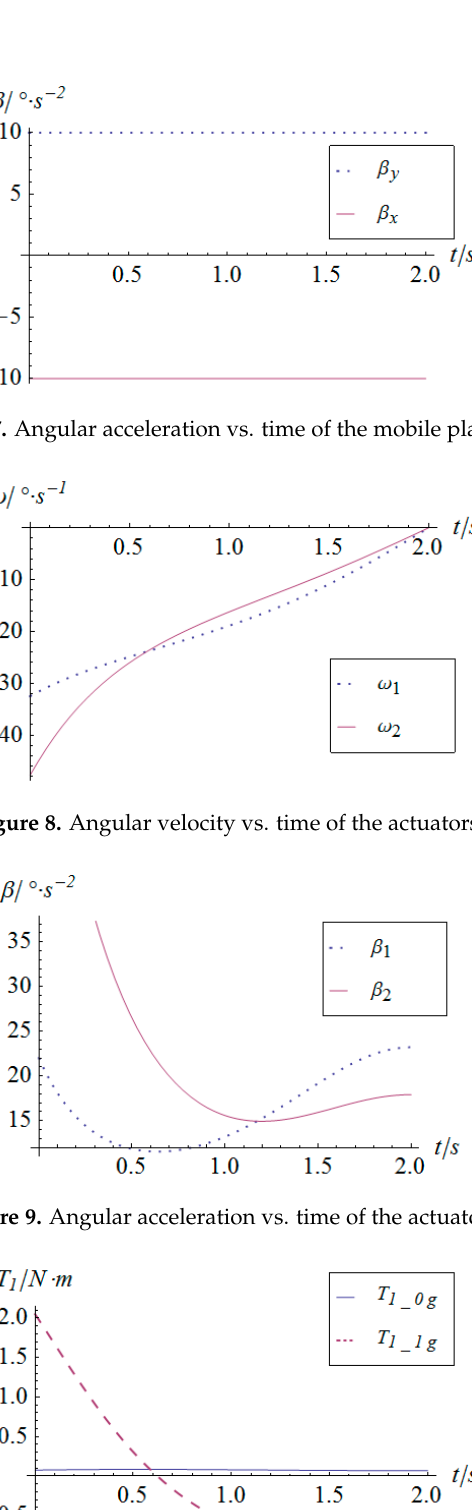
Figure 6. Angular velocity vs. time of the mobile platform.